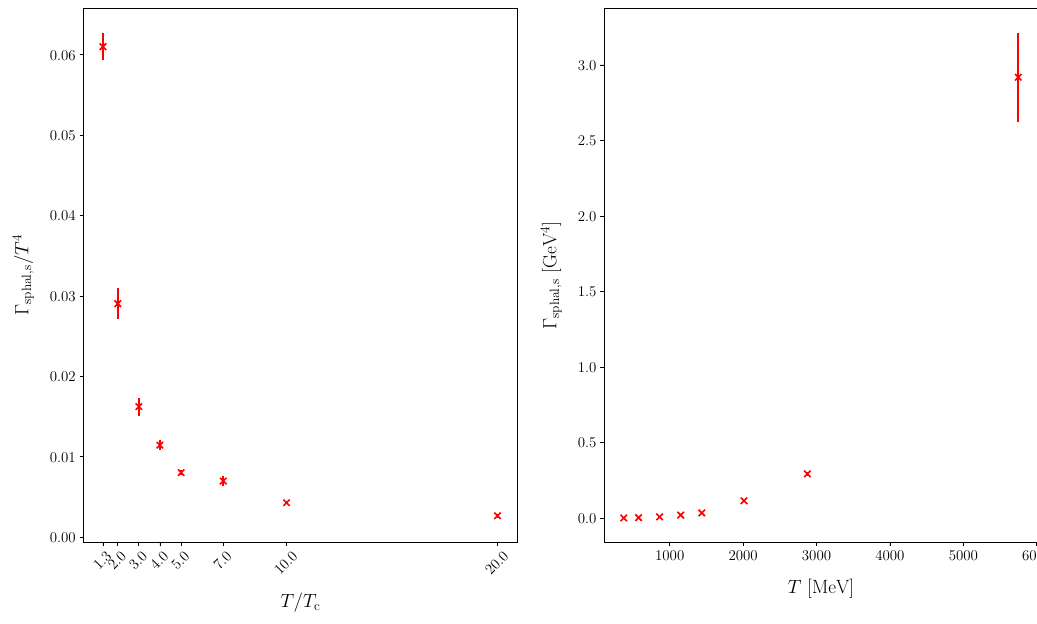
Figure 14 . Results for the sphaleron rate for different temperatures. The left plot presents the dimensionless ratio found by scaling with T 4 , while on the right we have reintroduced dimensions, using T c ≈ 280 MeV for SU(3) theory. Errors are statistical only; all data are at N t = 10 without a continuum extrapolation.